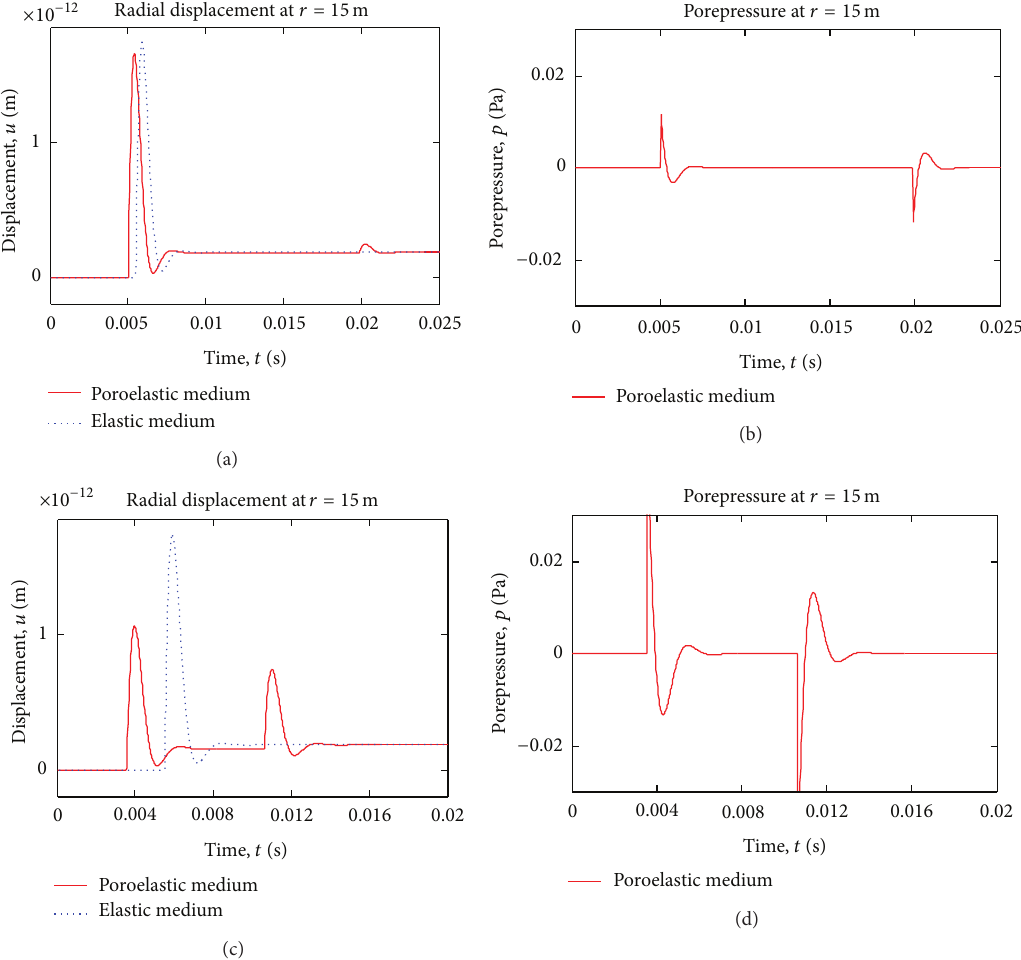
Figure 9: Time variation of radial displacement and pore pressure (step pulse case), for two different Biot moduli 𝑄 . ((a), (b)) are for 𝑄 = 0.5 × 1 0 10 Pa; ((c), (d)) are for 𝑄 = 3.5 ∗ 10 10 Pa.